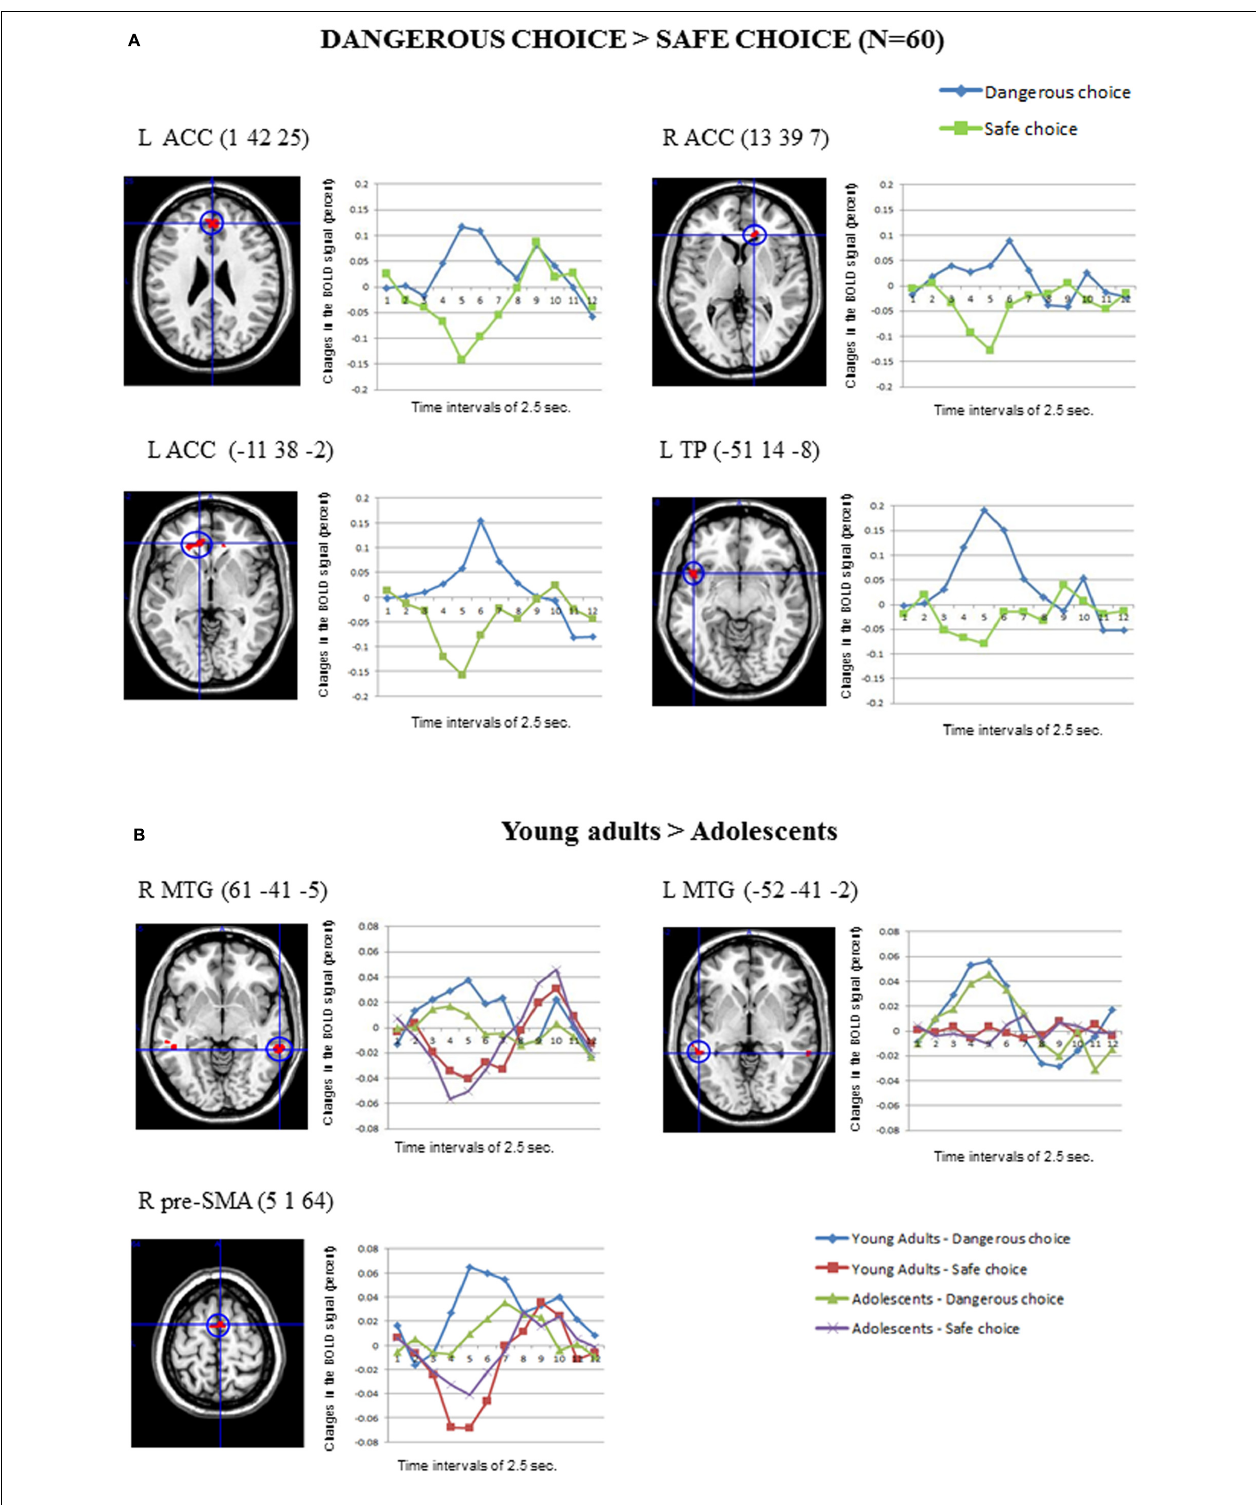
FIGURE 3 | (A) The clusters of activation in the whole-brain analyses for the contrast Dangerous > Safe choice (uncorrected threshold, p = 0.0001 and K > 10; N = 60) are circled for several regions. Changes in the BOLD signal (percent) across time for the same regions for the dangerous (blue) and safe (green) options are also shown, using time intervals of 2.5 s. (B) Differential